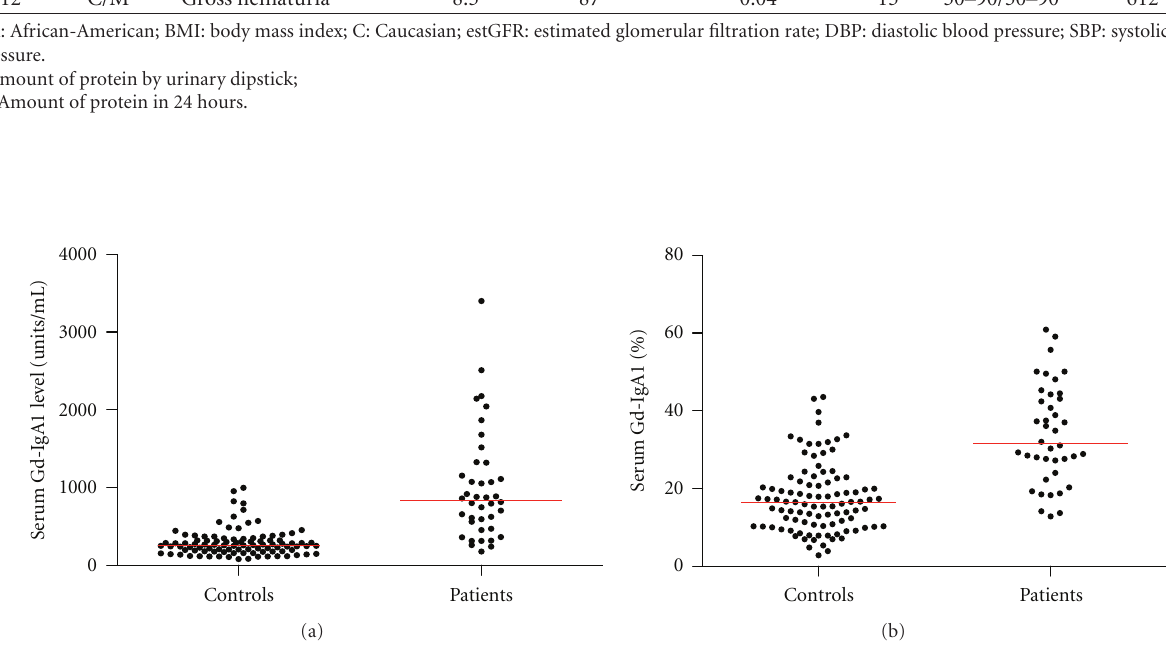
Figure 1: Serum levels of Gd-IgA1 plotted for the initial sample for 40 pediatric patients and 97 healthy pediatric controls. (a) Represented as units/mL serum. Median is represented for each group. The serum level was significantly higher for the patient group ( P < 0 . 0001). (b) Represented as percentage of total IgA. Median is represented for each group by the red bar. The serum level was significantly higher for the patient group ( P < 0 .